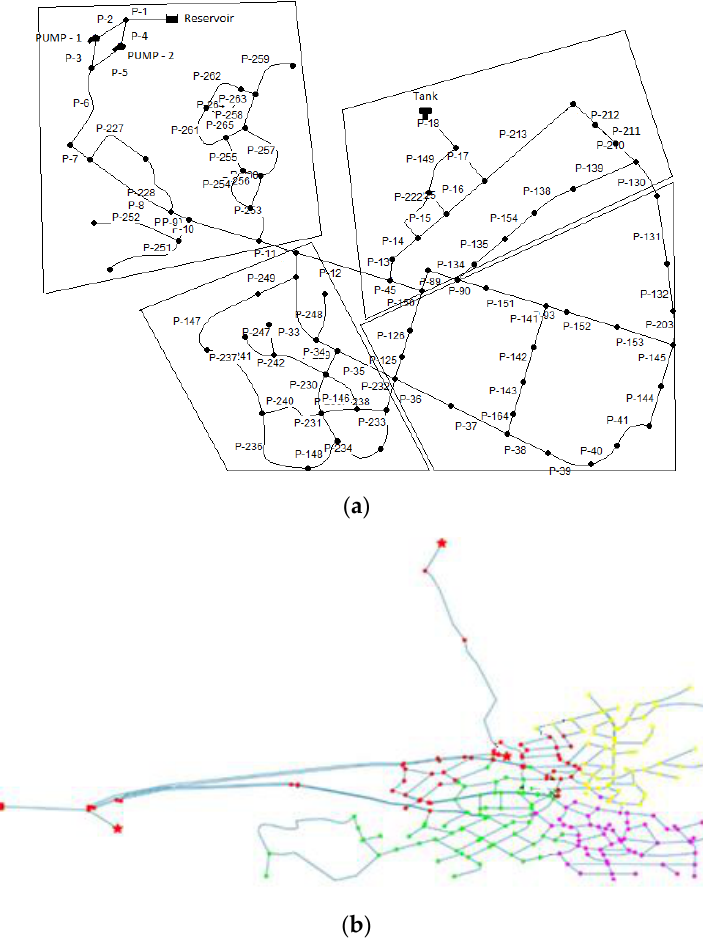
Figure 4. Forming the networks ’ DMAs : ( a ) Net 22 and ( b ) Aiani into sub-regions using Geometric